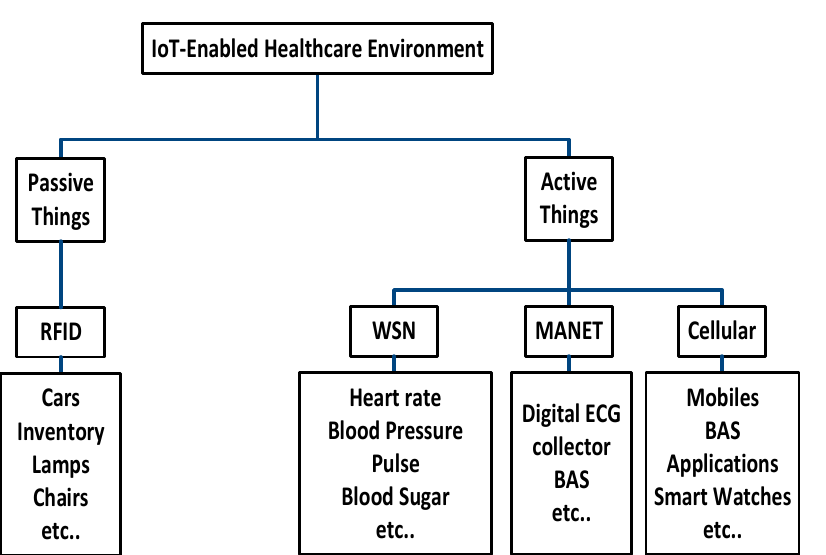
Figure 7. Device classification in the proposed IoT-enabled healthcare architecture. Table 3. Partial of simulation